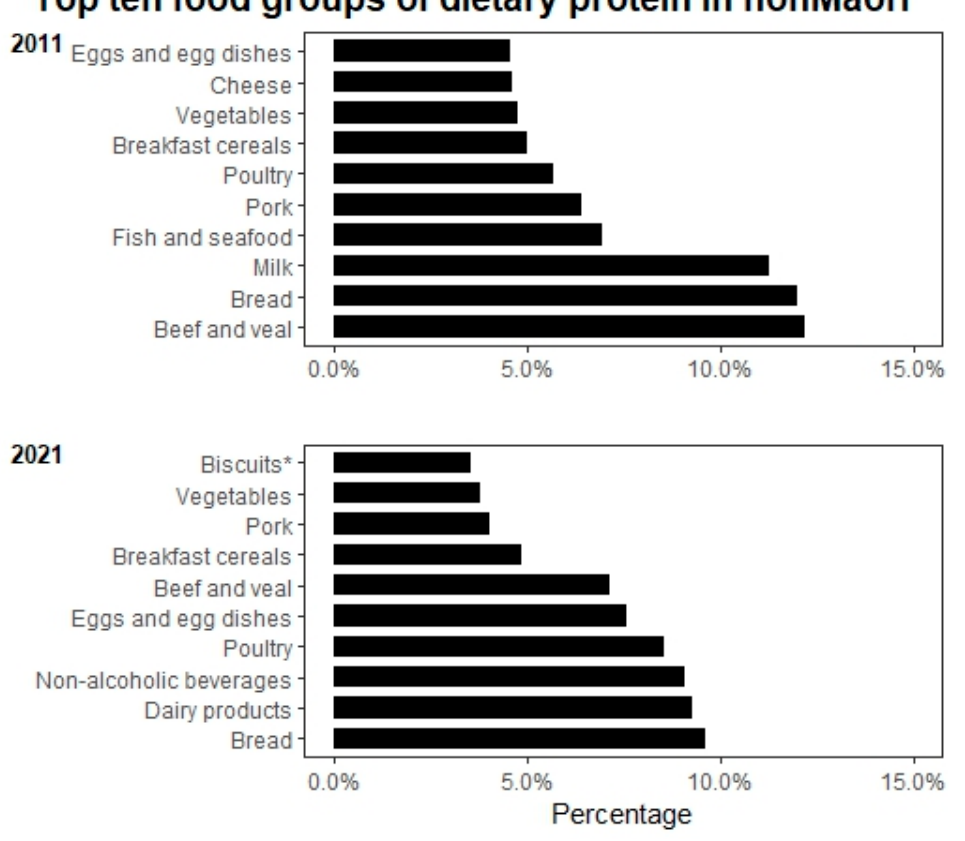
Figure 3. Top ten food groups of dietary protein intake for non-M¯aori in 2011 and 2021. Notes: Clas- si fi cation of food groups were based on the 2008/09 New Zealand Adult Nutrition Survey NZ food groups. * Sweet biscuits (plain, chocolate coated, fruit fi lled, cream fi lled), crackers.